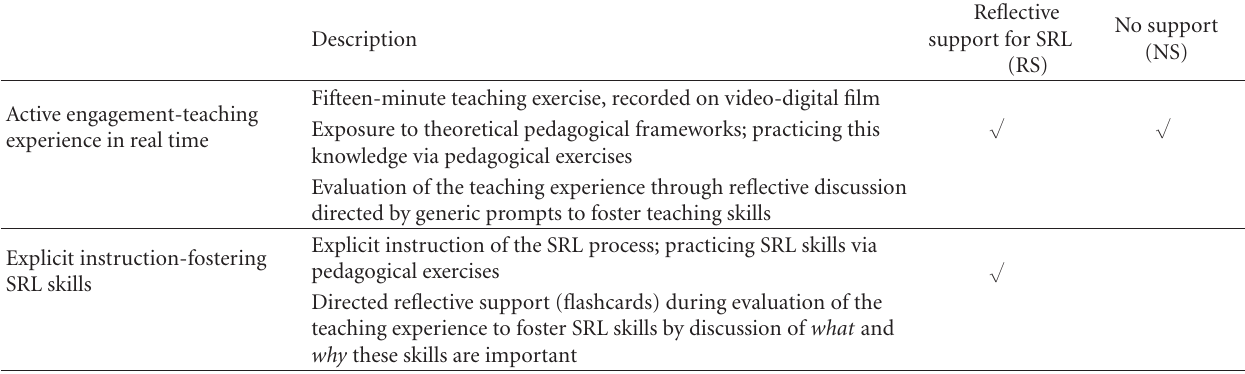
Table 1: Layout of experimental design, by group (reflective support/no support for SRL).